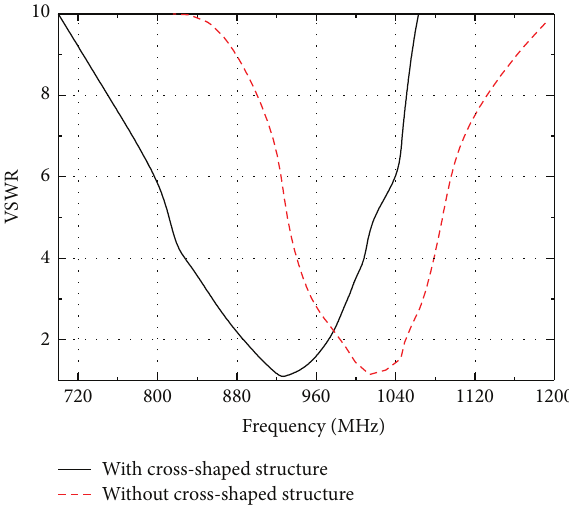
Figure 3: Permeability versus frequency for cross-shaped structure.